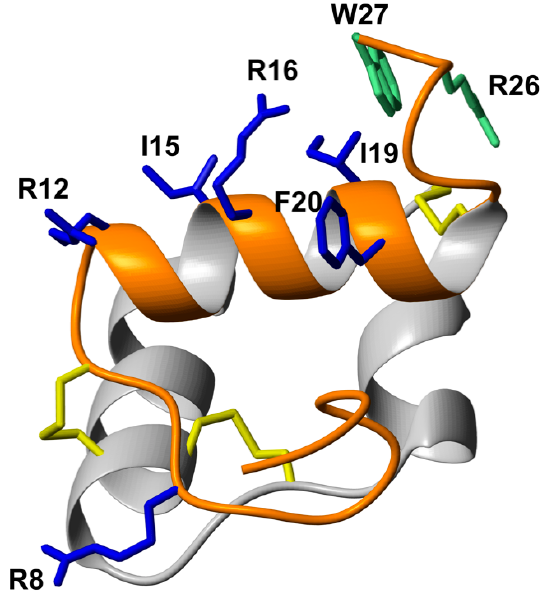
Figure 1. Three-dimensional structure of relaxin-3. The A-chain and B-chain are shown in grey and dark orange respectively. The structure is braced by an intra-chain disulfide in the A-chain and two inter-chain disulfide bonds, shown in yellow. Residues in blue are important for binding to RXFP3, whereas the green residues are required to activate the receptor.